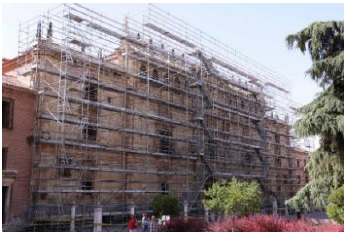
Figure 1: Façade University of Alcala. Restoration, 2017.